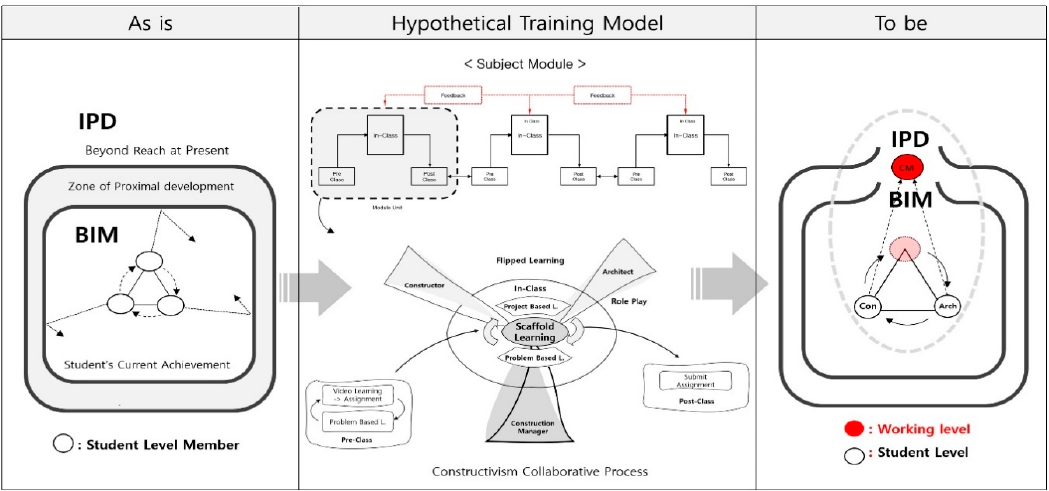
Figure 4. “CCP” model to improve BIM/IPD collaboration training.